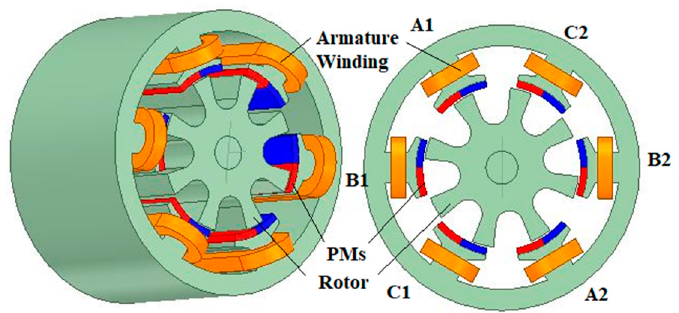
Figure 17. A typical 3D and 2D structures of designed FRM.